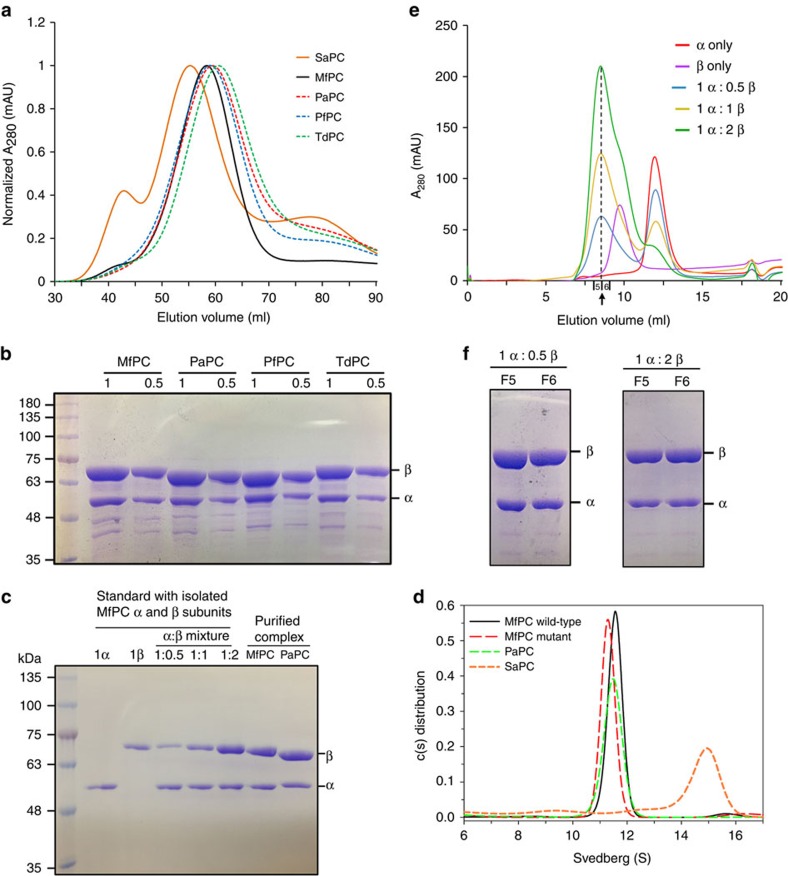
Experiments to confirm α2β4 stoichiometry of two-subunit PCs.(a) Gel filtration profiles for two-subunit PCs (Mf, M. flagellates; Pa, P. aeruginosa; Pf, P. fluorescens; Td, T. denitrificans) and the single-chain SaPC. (b) Coomassie-stained SDS–PAGE gel with purified two-subunit PCs from different species. Two lanes were run for each protein, with twice as much protein loaded in the first lane. The band for the α subunit in this lane is roughly the same as that for the β subunit in the second lane, consistent with the 1:2 stoichiometry. (c) SDS–PAGE gel with known amounts of α and β subunits and their mixtures, indicating that the purified holoenzyme has 1:2 stoichiometry. The β subunit in the MfPC holoenzyme sample is slightly smaller than the β subunit sample alone as it does contain a His tag. (d) Size distribution of PCs in solution at a concentration of 0.5 mg ml−1, based on the best-fit results by the continuous size distribution analysis. Two-subunit PCs (MfPC wild-type and deletion mutant, and PaPC) showed a similar major species of S=11.5, while single-chain SaPC showed a tetrameric species of S=14.8. (e) Gel filtration profiles from mixing experiments of different ratios of MfPC α and β subunits. The vertical dashed line indicates the elution volume of the complex that is formed on mixing. (f) Coomassie-stained SDS–PAGE gels of peak fractions collected from two different mixing experiments (F5 and F6 indicates collected fractions 5 and 6, respectively, indicated in e).